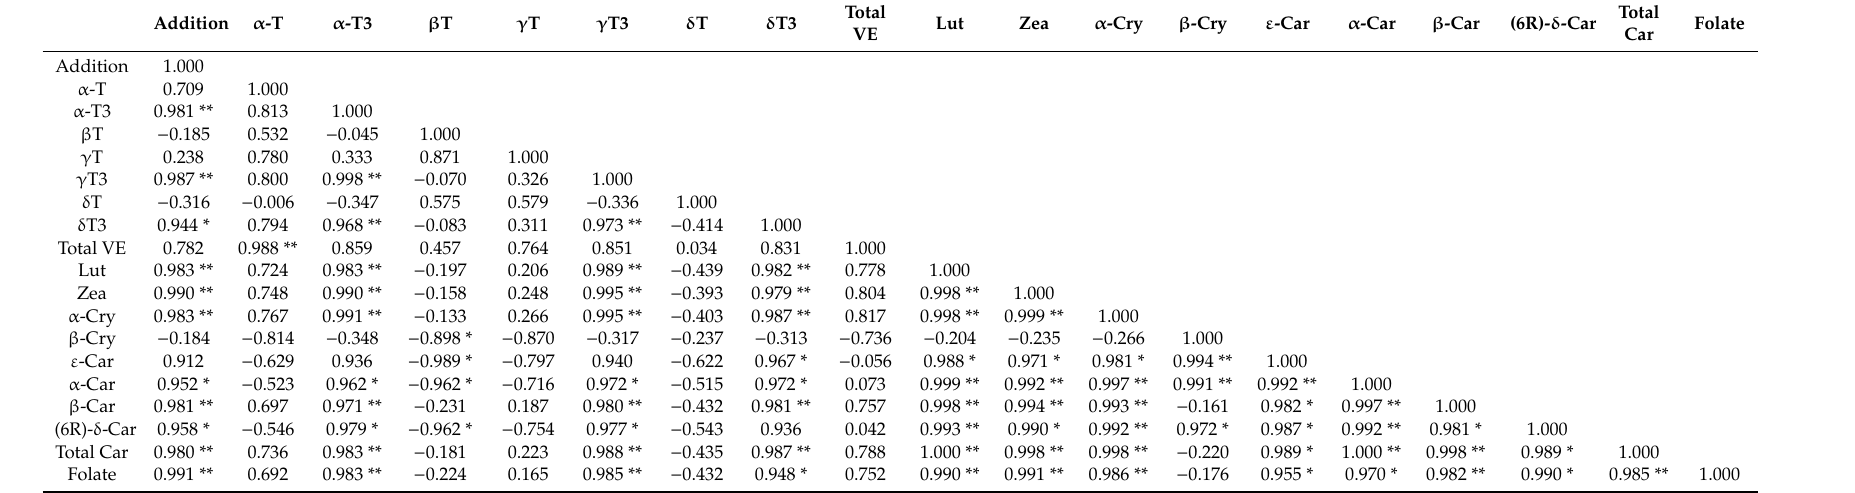
Table 8. Correlation between SCR addition and detected micronutrient